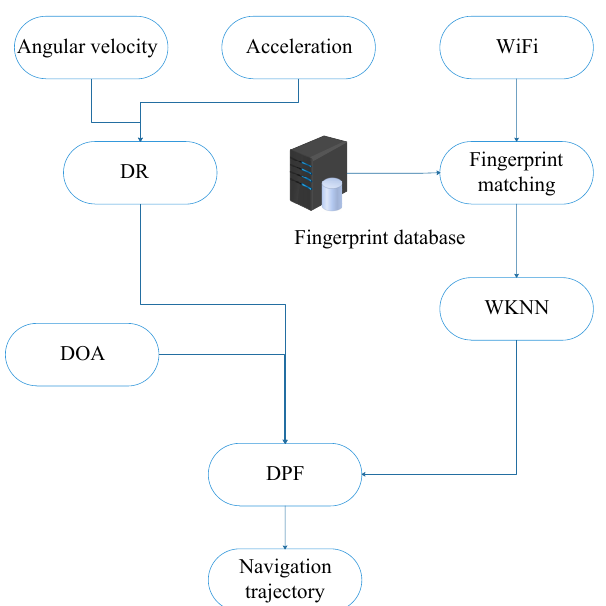
Figure 1. The structure of the indoor localization